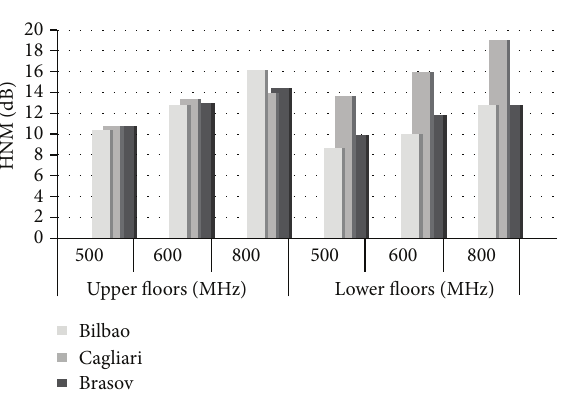
Figure 6: HNM for the three cities in urban environment.